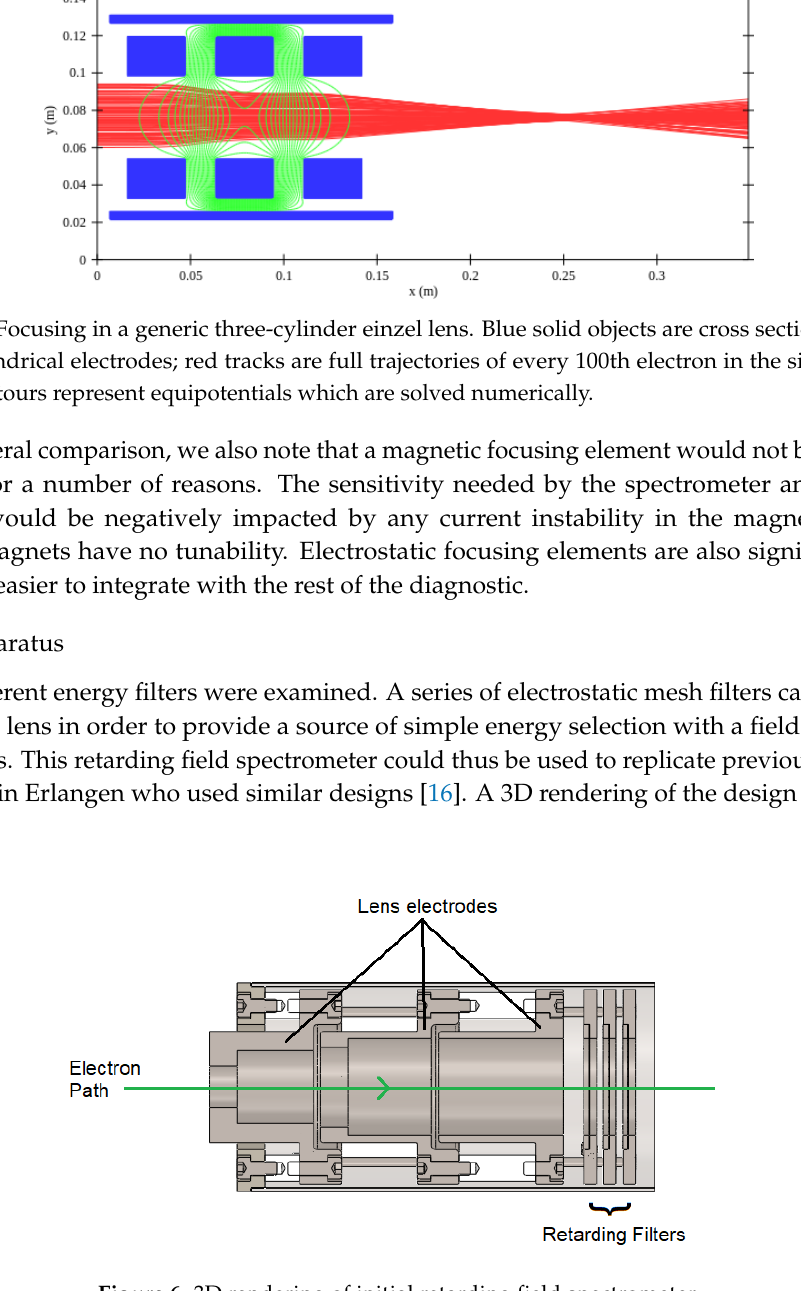
Figure 6. 3D rendering of initial retarding field